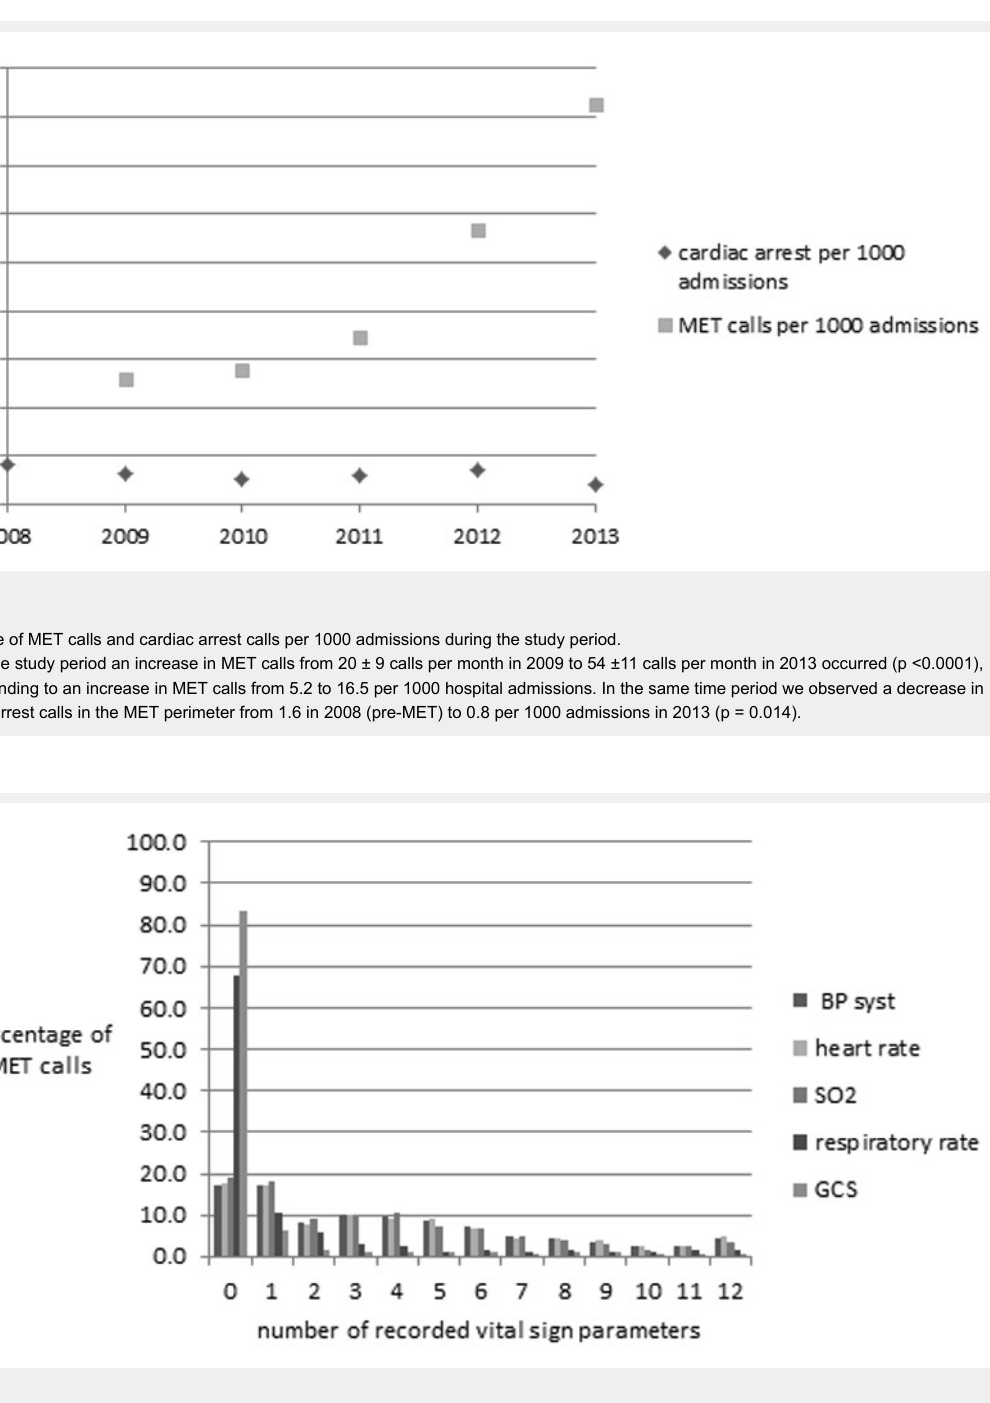
Figure 2 Number of vital sign parameters recorded during the 24 hours before MET calls. In a substantial number of MET calls vital sign measurements had been performed only infrequently and incompletely in the antecedent 24 hours before the MET event. In 83% of MET calls no assessments of GCS and in 68% no assessment of respiratory rate was